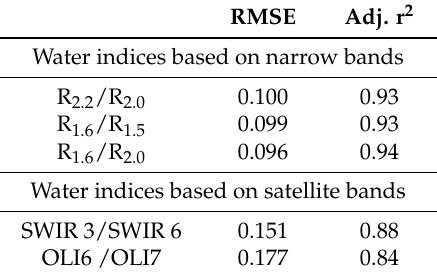
Table 6. Root mean square error (RMSE) and adjusted coefficient of determination (Adj. r 2 ) for the relative water content (RWC) measured in the field and estimated by the equations from the laboratory experiment, as a function of the water indexes based on narrow bands (Figure 6) or on satellite bands (Figure 7) extracted from the reflectance spectra measured in the field ( n = 410). RMSE Adj. r 2 Water indices based on narrow bands R 2.2 /R 2.0